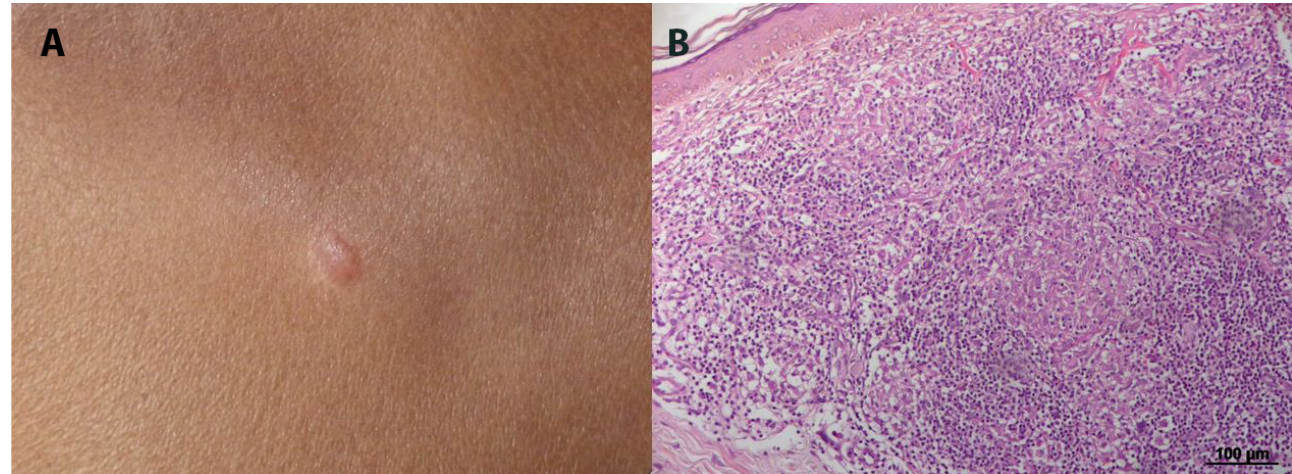
Figure 1. Clinical feature of the skin lesion of non-ulcerated or atypical cutaneous leishmaniasis. (A) Macroscopic lesion. (B) Histological sections showing the mononuclear inflammatory infiltrate in the dermis